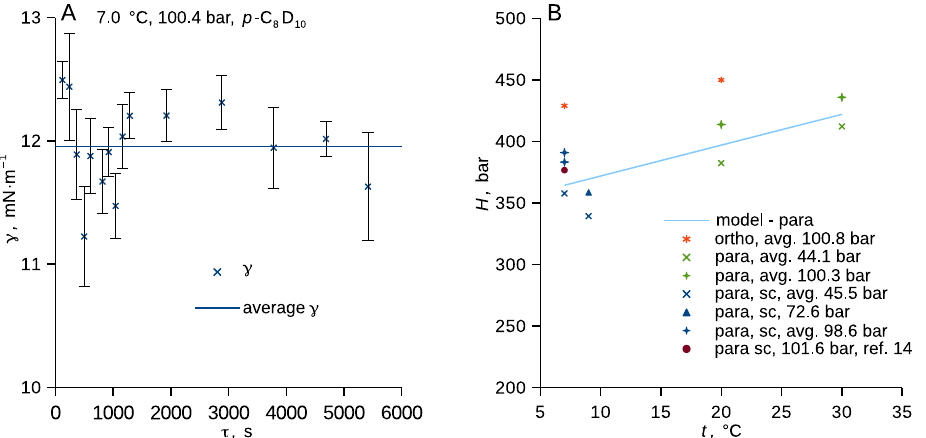
Figure 5. ( A ) Surface tension as a function of time upon exposure to pressurized methane, error bars show uncertainty due to random errors calculated using Bonferroni method 57 , line shows the average. ( B ) Henry’s law constant, see Eq. (5), of methane in the studied deuterated xylenes is shown together with the temperature dependence of Henry’s the constant for all data (this work) for perdeuterated p -xylene with the enthalpy of dissolution of − 4.5 kJ ⋅ mol −1 and datum calculated based on the literature 14 using Eq. (5); sc abbreviates